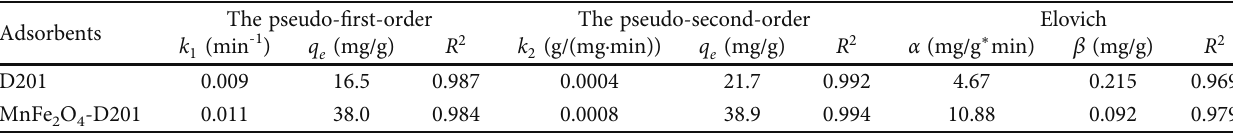
Figure 5: Adsorption kinetics of As(V) at 298 K (a – c). Adsorption isotherm of As(V) at 298 K, 318K, and 338 K (d – f) (the uniform experimental condition: 100mL of As(V) with 50 mg D201 or MnFe 0-360 min and 30mg/L As(V); adsorption isotherm: temperature at 298K, 318 K, and 338K, As(V) concentration range is 30 to 100mg/L). Table 1: As(V) adsorption kinetic model constants derived from the pseudo- fi rst-order, the pseudo-second-order equation, and the Elovich model.